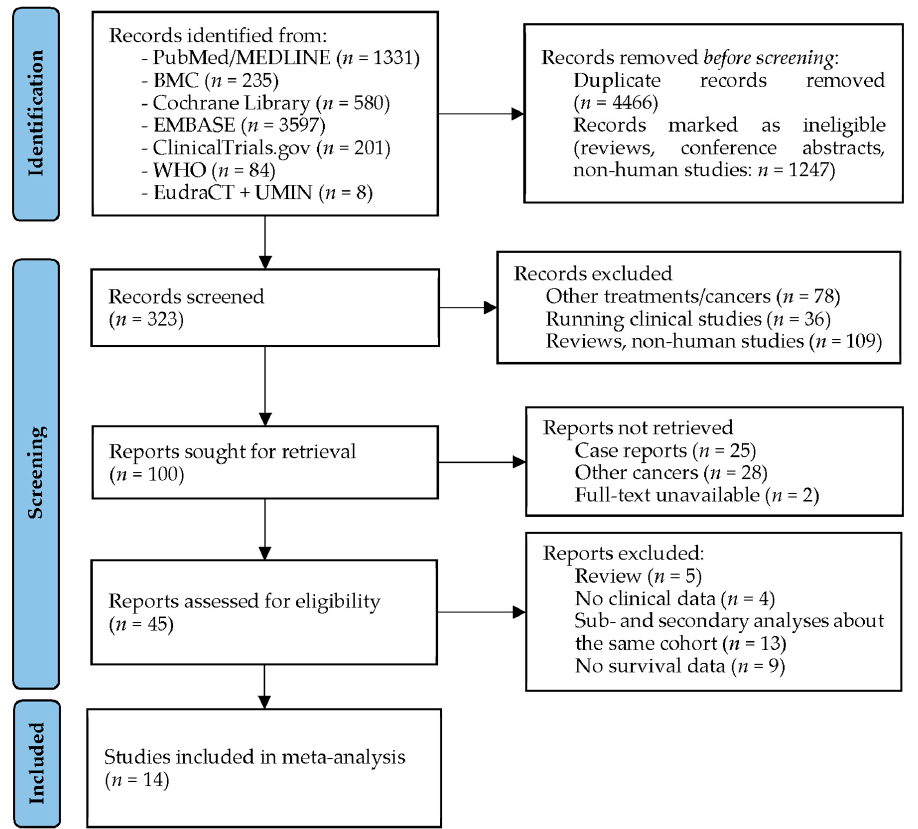
Figure 4. PRISMA flow diagram of studies about Tumor Treating Fields. BMC: BioMed Central; EMBASE: Excerpta Medica Database; EudraCT: European Union Drug Regulating Authorities Clinical Trials Database; MEDLINE: Medical Literature Analysis and Retrieval System Online; WHO: